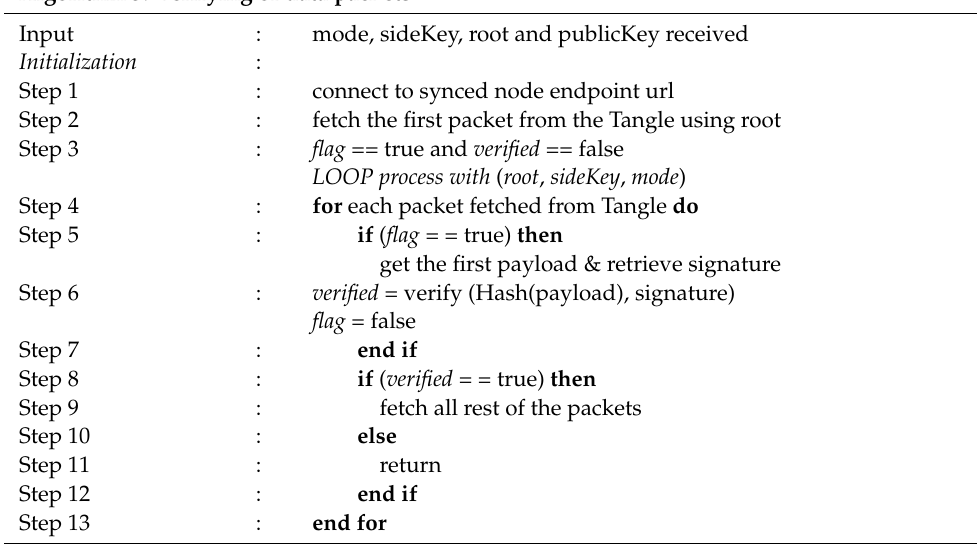
Algorithm 3. Verifying of data